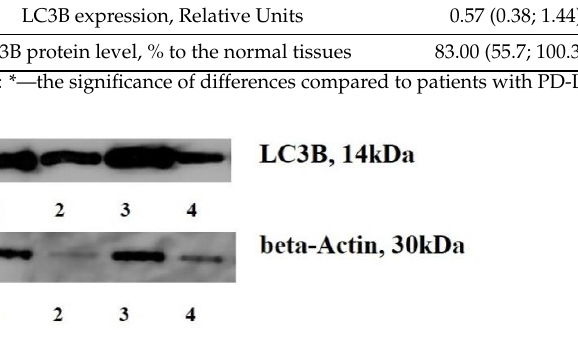
Figure 1. LC3B content in GCs tissues and adjacent non-transformed ones. (Figure 1. Note: 1, 3 – cancers, 2,4 — non-transformed tissues; LC3B content is a key oncogenic event in GCs development, indicating the autophagy initiation. The modified biological features in cancers after the NACT are responsible for the development of anti-cancer therapy resistance).